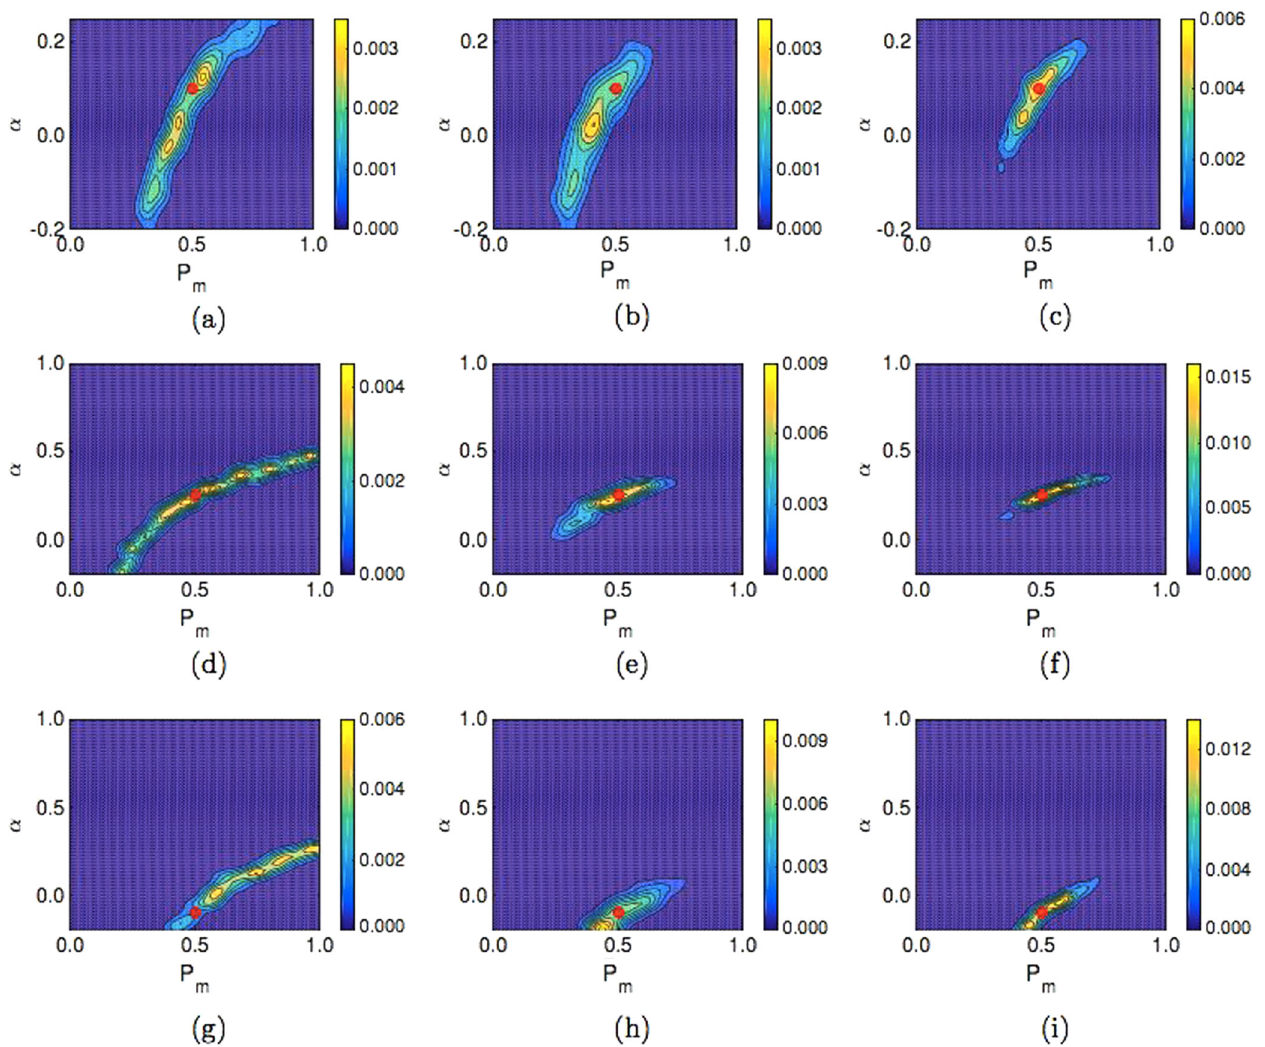
Fig. 1 a – c Posterior distributions for model A for an unrealistic experiment with different summary statistics: a average displacement of agents in the horizontal direction; b agent density pro fi le; c PCF. In all cases the red dot indicates the value of the parameters used to generate the synthetic data, P m = 0.5, α = 0.1. As indicated by the colour bar the yellow regions indicate areas of high relative density of the posterior distribution, while the blue regions indicate areas of low relative density of the posterior distribution. d – f Model B, P m = 0.5, α = 0.25: d average displacement of agents in the horizontal direction; e agent density pro fi le; f PCF. g – i Model B, P m = 0.5, α = − 0.1; g average displacement of agents in the horizontal direction; h agent density pro fi le; i